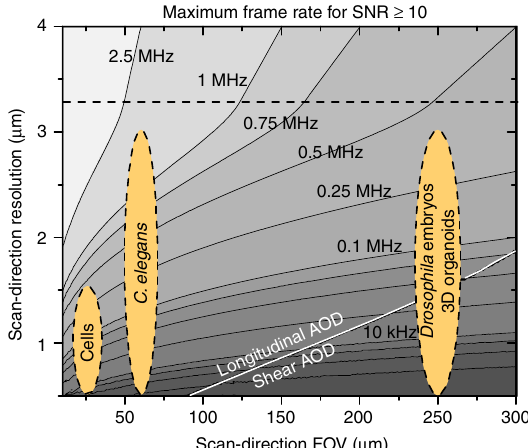
Fig. 5 LEAD fl uorescence microscopy can be adapted to meet a wide-range of parameter space requirements of other biological samples. Here, we present the theoretical maximum achievable frame rates when imaging samples labeled with 1 µ M fl uorescein equivalent using a TeO 2 AOD with 150 MHz bandwidth and 5 mm aperture (AODs #3 and #4 in Supplementary Table 2) while maintaining an SNR ≥ 10 (Supplementary Note 4). The FOV and resolution de fi ne the number of resolvable spots